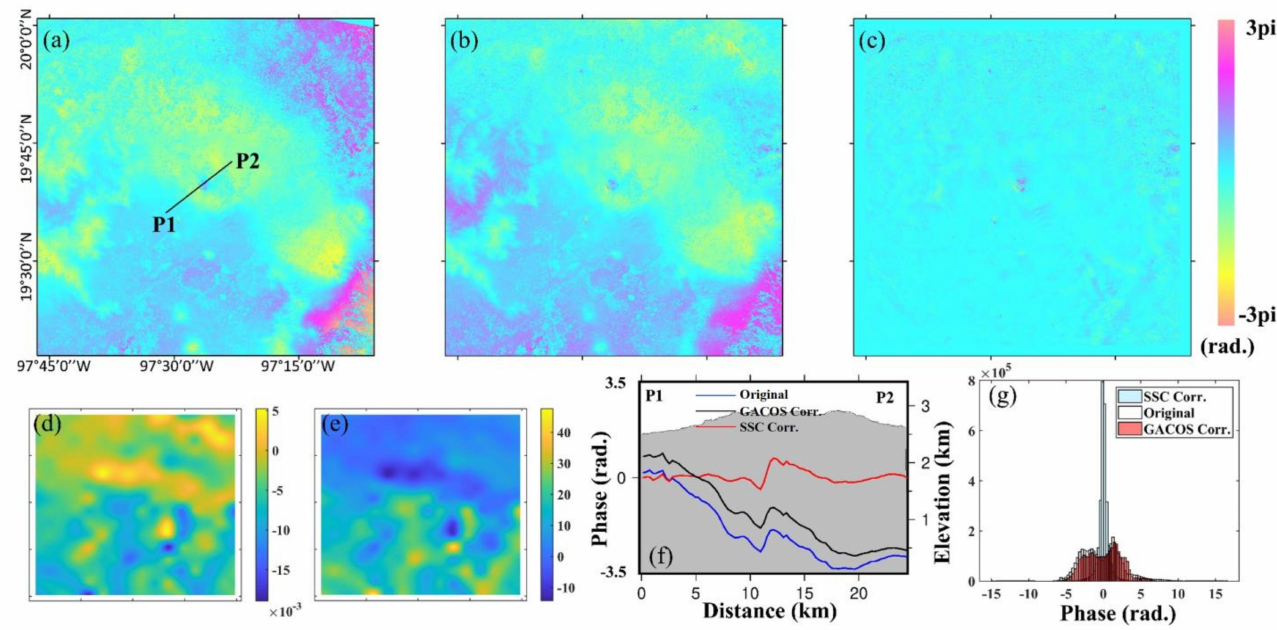
Figure 2. Examples of atmospheric correction: ( a – c ) are original, GACOS-corrected-, and SSC- corrected interferograms of the Mw 4.83 Mexico earthquake;( d ) is the scale factor map; ( e ) is the offset factor map; ( f ) shows the phase changes along cross section P1–P2 in ( a ); ( g ) is the histogram of ( a – c ) after masking the main coseismic